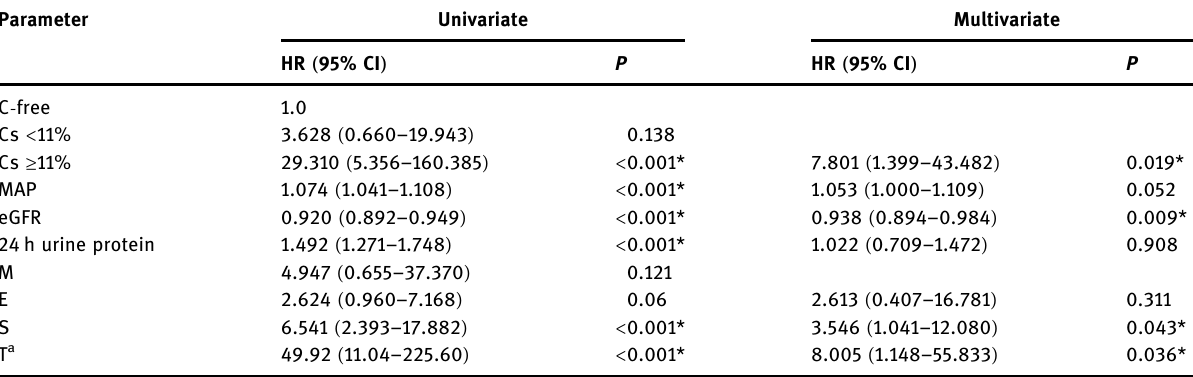
Table 5: Cox regression analysis of the C score for prognostic prediction of IgAN patients